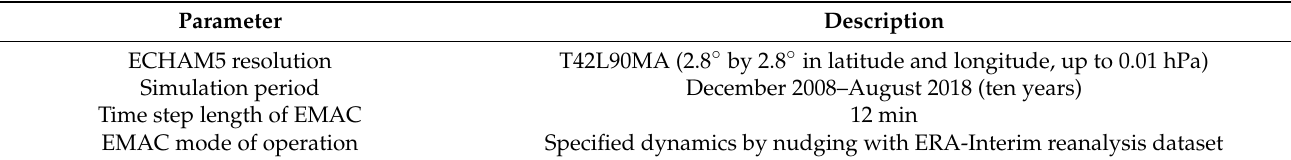
Table 1. Setup for the European Center Hamburg general circulation model (ECHAM) and the Modular Earth Submodel System (MESSy) Atmospheric Chemistry (EMAC) model